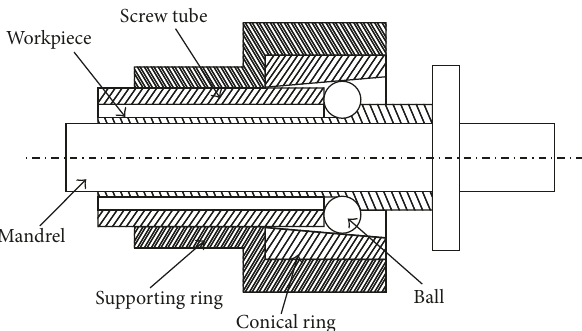
Figure 1: Schematic of ball spinning.